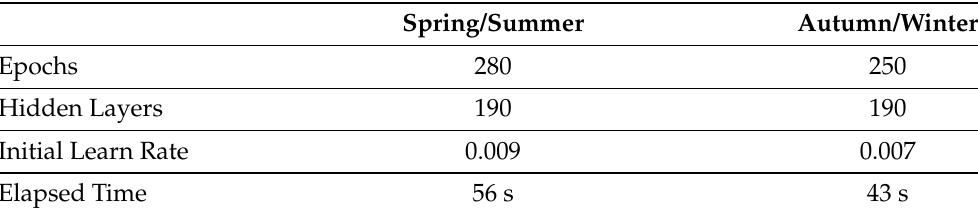
Table 6. Summary of Neural Network architecture in Matlab for the summer and winter